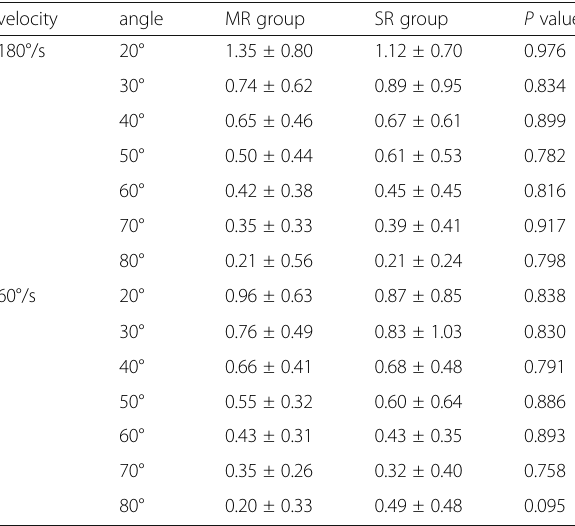
Table 4 Angle-specific extension torque (mean ± SD) at 180°/s and 60°/s